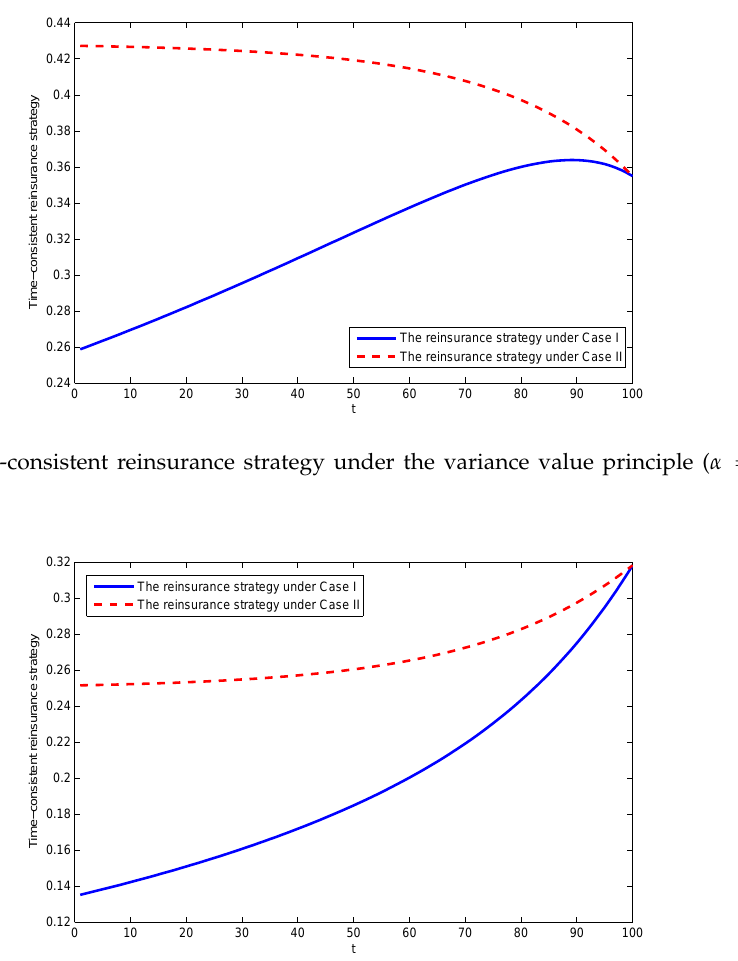
Figure 6. Time-consistent reinsurance strategy under the variance value principle ( α = 0.6 and T =